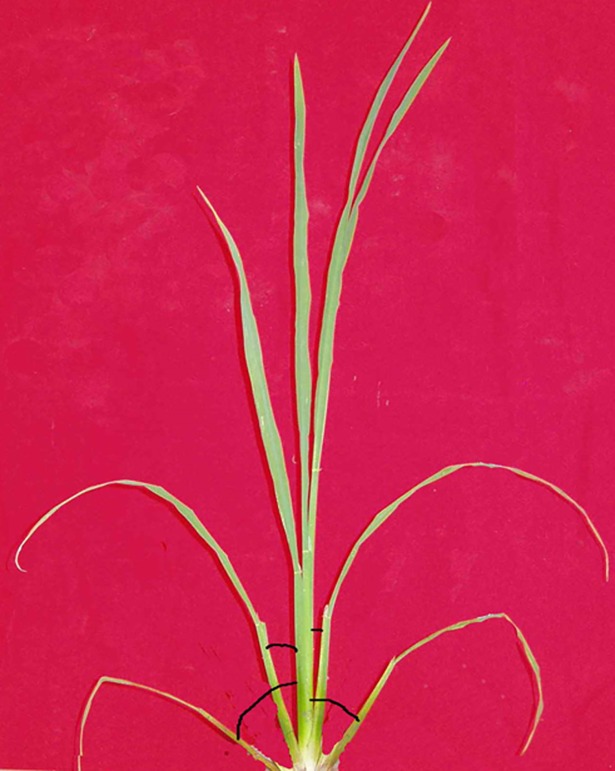
Real map of SSA.